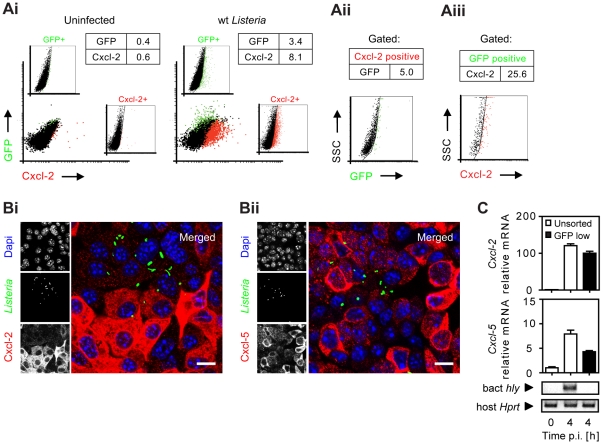
Analysis of bacterial infection and epithelial activation at the single cell level.(A) m-ICcl2 cells were left uninfected (Ai, left) or infected with wt PactA-gfp L. monocytogenes (Ai, right). The number [%] of GFP+ (Listeria-infected, green) or immunolabelled Cxcl-2+ (red) cells was visualized 4 h after infection by flow cytometry. Single channel analysis (GFP: FL-1; Cxcl-2: FL-4) was depicted on the side of the axis. (Aii) The number of GFP+ (Listeria-infected) cells among activated, Cxcl-2+ cells and (Aiii) the proportion of Cxcl-2+ cells among GFP+ (Listeria-infected) cells was demonstrated gating on the respective population. (B) m-ICcl2 cells were infected with wt PactA-gfp L. monocytogenes. Intracellular Listeria (GFP+, green) and immunolabelled (Bi) Cxcl-2 (red) or (Bii) Cxcl-5 (red) was visualized 4 h after infection by fluorescence microscopy. Magnification ×400, counterstaining with Dapi (blue). Scale bar, 5 µm. (C) m-ICcl2 cells were infected with actA mutant L. monocytogenes expressing constitutively GFP under control of the sod promoter (Psod-gfp). 4 h after infection the GFPlow expressing (Listeria-negative) cell fraction was sorted by flow cytometry (see Fig. S2C) and analysed for Cxcl-2 (upper) or Cxcl-5 (lower) mRNA expression by RT-PCR. The absence of detectable Listeria in the sorted GFPlow cell fraction was demonstrated by PCR amplification of the bacterial hly gene (sensitivity limit: 103–104 genome copies). All experiments were performed at a multiplicity of infection of 100∶1. Results are representative for three independent experiments and are presented as mean ± SD (RT-PCR) or show one representative experiment.